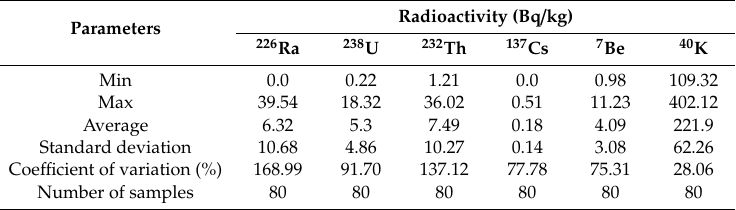
Table 6. Statistic of characterization of radioactivity in food